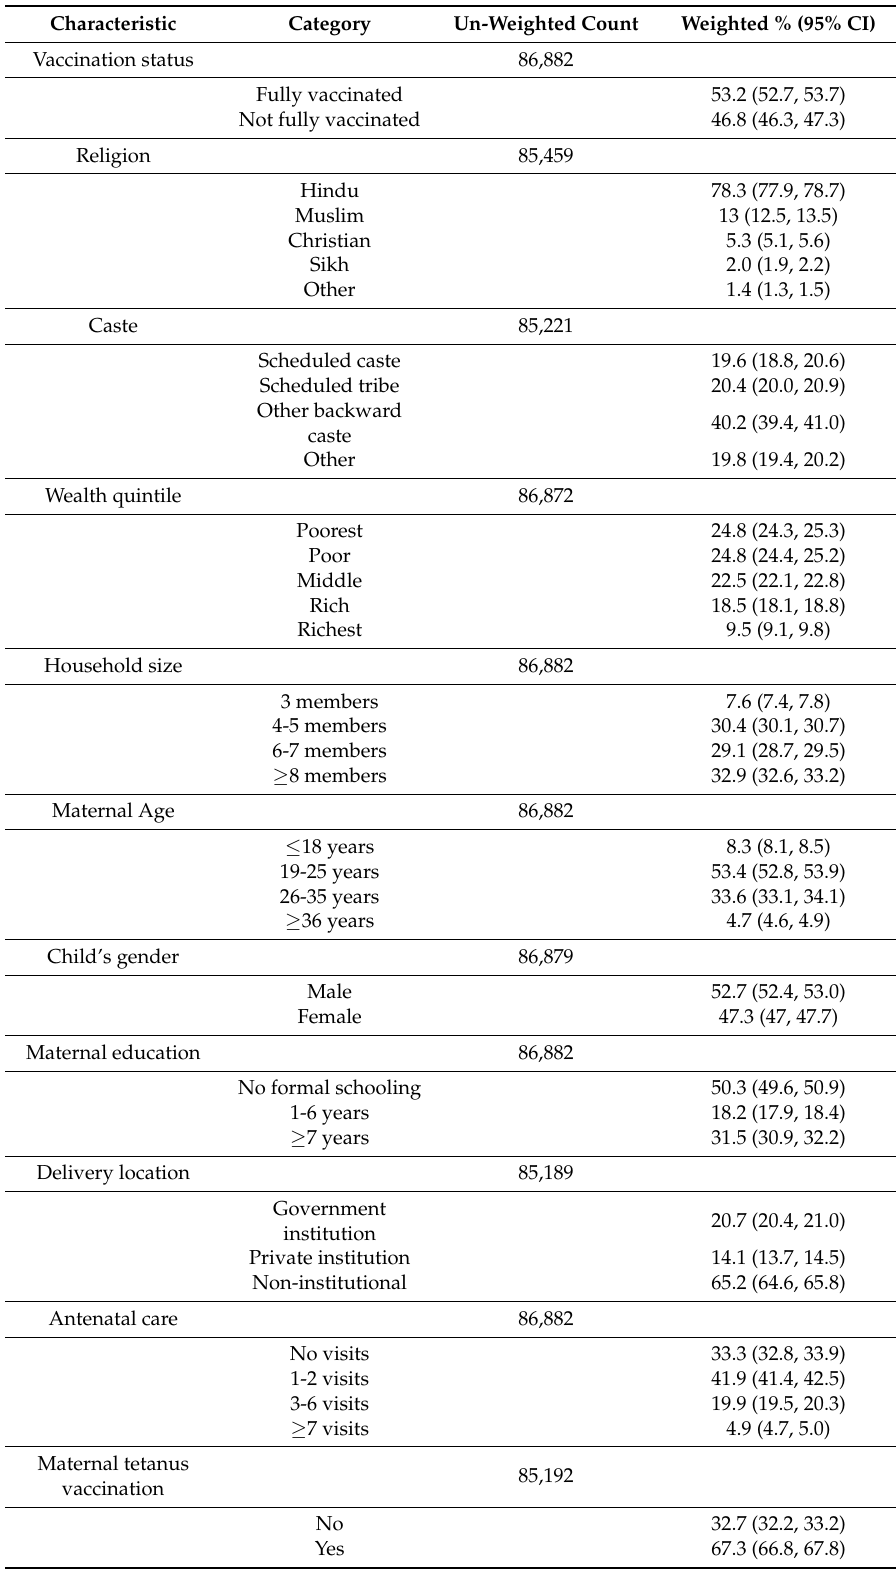
Table 1. Individual-level characteristics of Indian children aged 12 to 36 months,